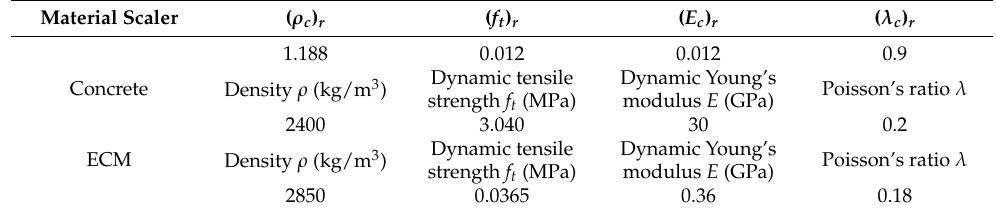
Table 3. The material